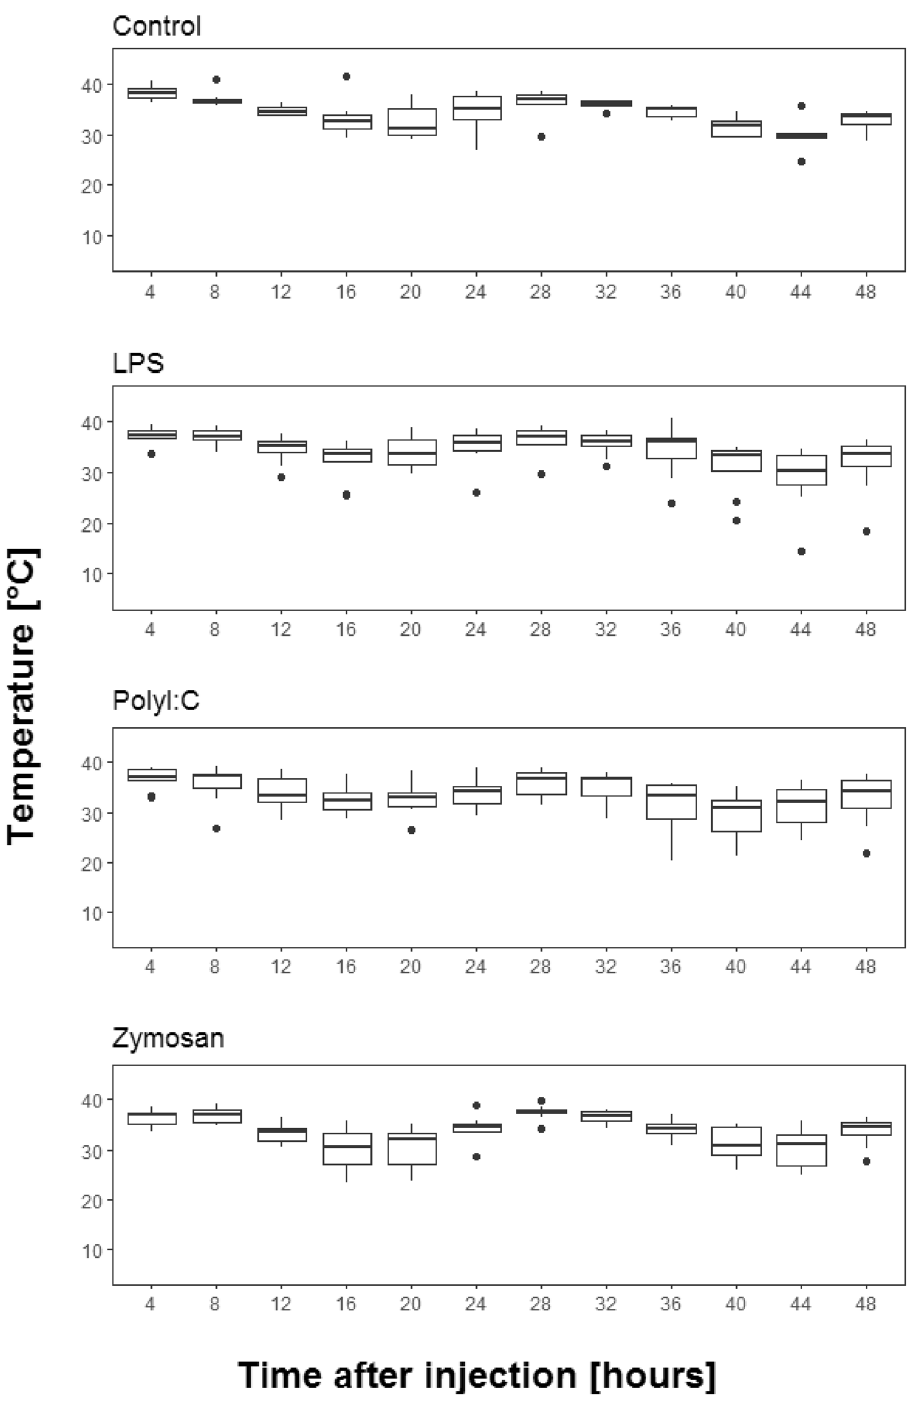
Figure 1. Skin temperature (°C) of bats following injection of saline solution (control), LPS, PolyI:C and zymosan (time after injection = 0 h, not depicted). The figures show medians (bold line), 25–75% percentiles (box), maxima and minima (whiskers) and outliers